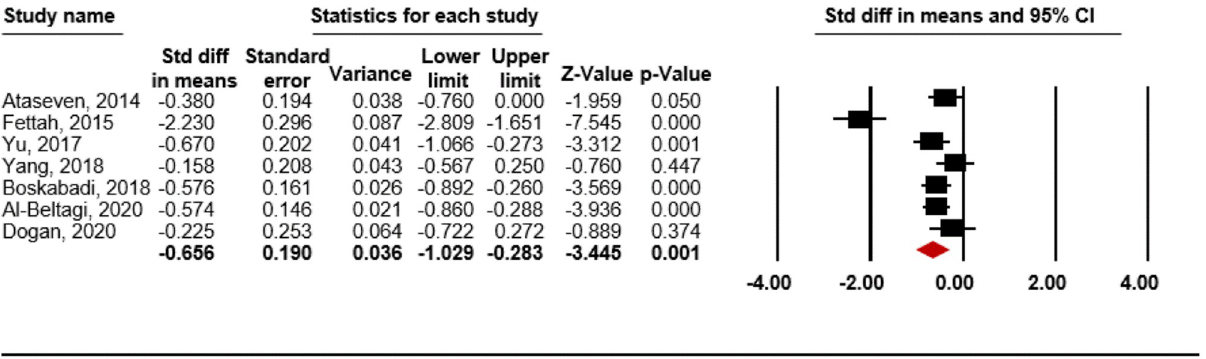
Fig 3. Meta-analysis for the association between vitamin D level and respiratory distress